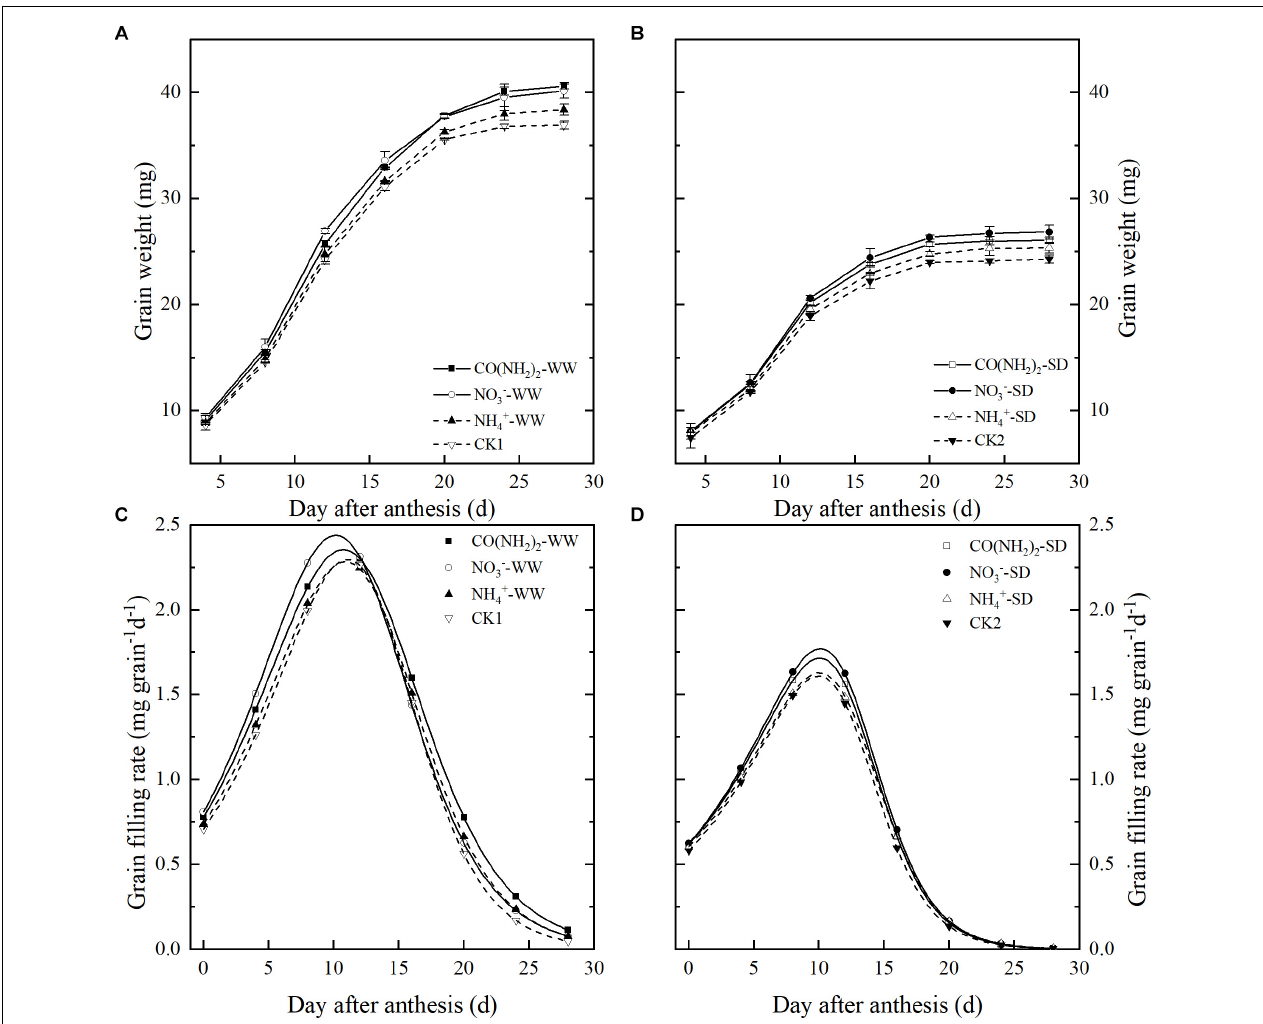
FIGURE 1 | Effect of N forms in foliar fertilizer on grain weights [ (A) well-watered treatment, WW; (B) soil-dried treatment, SD] and grain filling rates [ (C) well-watered treatment, WW; (D) soil-dried treatment, SD]. Vertical bars represent ± the standard deviation of the mean ( n = 3). CO(NH 2 ) 2 , NO 3 − , and NH 4 + represent CO(NH 2 ) 2 , NaNO 3 , and NH 4 Cl, whose concentration was described in the Materials and Methods section. CK1 and CK2 mean that deionized water was sprayed on leaves at anthesis under well-watered treatment and soil-dried treatment,